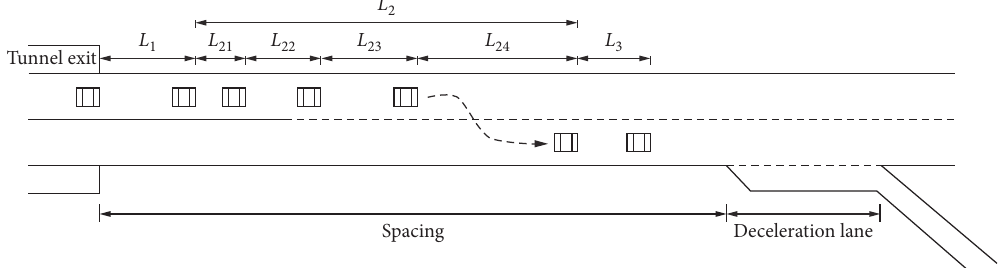
Figure 3: Test model. L 1 is the “light adaptation” distance; L 2 is the traverse distance; L 21 is the wait insertion distance; L 22 determines whether it is the distance of the inserted gap; L 23 is the adjusting distance; L 24 is the transverse distance to the inner lane; L 3 is the safety confirmation distance.